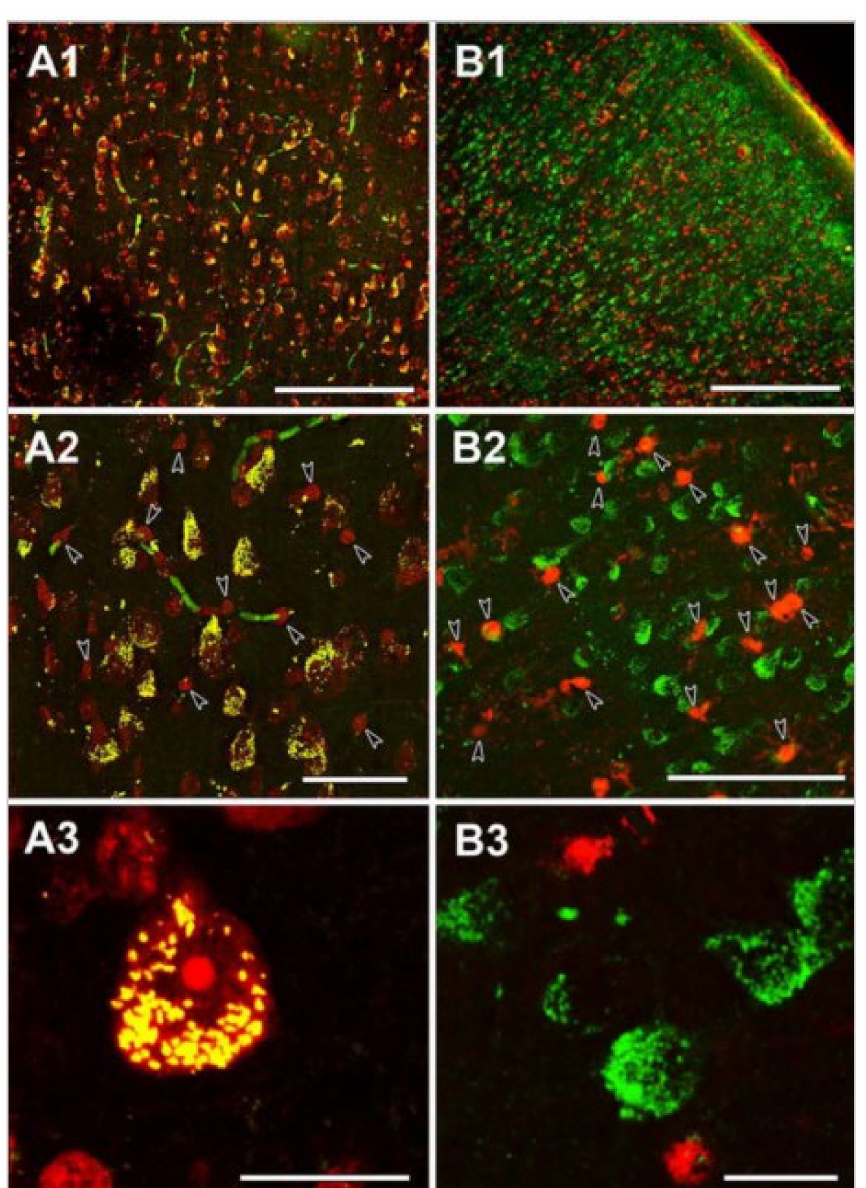
Figure 2. The neuronal localization of SUCLA2 immunoreactivity in the human temporal cortex. ( A1 ): The distribution of SUCLA2-positive cells is similar to that of Nissl-labeled cells (red), both present throughout the temporal cortex. ( A2 ): A higher magnification image reveals that essentially all large Nissl-labeled cells with irregular shape demonstrate SUCLA2 immunolabeling (yellow cells). In contrast, small, intensely labeled round-shape cells do not exhibit SUCLA2 immunoreactivity and remain red (arrowheads). Some blood vessels are labeled green because of the peroxidase activity of the red blood cells present in the vessels in the non-perfused human tissue. ( A3 ): A high-magnification confocal microscopy image demonstrating the punctuate location of SUCLA2 immunoreactivity within the Nissl-labeled neurons whereas small glial cells do not exhibit SUCLA2 immunoreactivity. ( B1 ): The distribution of the glial marker S100 (red) is different from that of SUCLA2-positive cells (green). ( B2 ): A higher magnification image demonstrates lack of colocal- ization between SUCLA2 and S100. Glial cells labeled with S100 are indicated by arrowheads. ( B3 ): High-magnification confocal picture shows that SUCLA2 and S100 are located in different cell types. Scale bars 200 µ m for ( A1 ), 50 µ m for ( A2 ), 20 µ m for ( A3 ), 500 µ m for ( B1 ), 50 µ m for ( B2 ), and 20 µ m for ( B3 ). (Adapted from [98], by